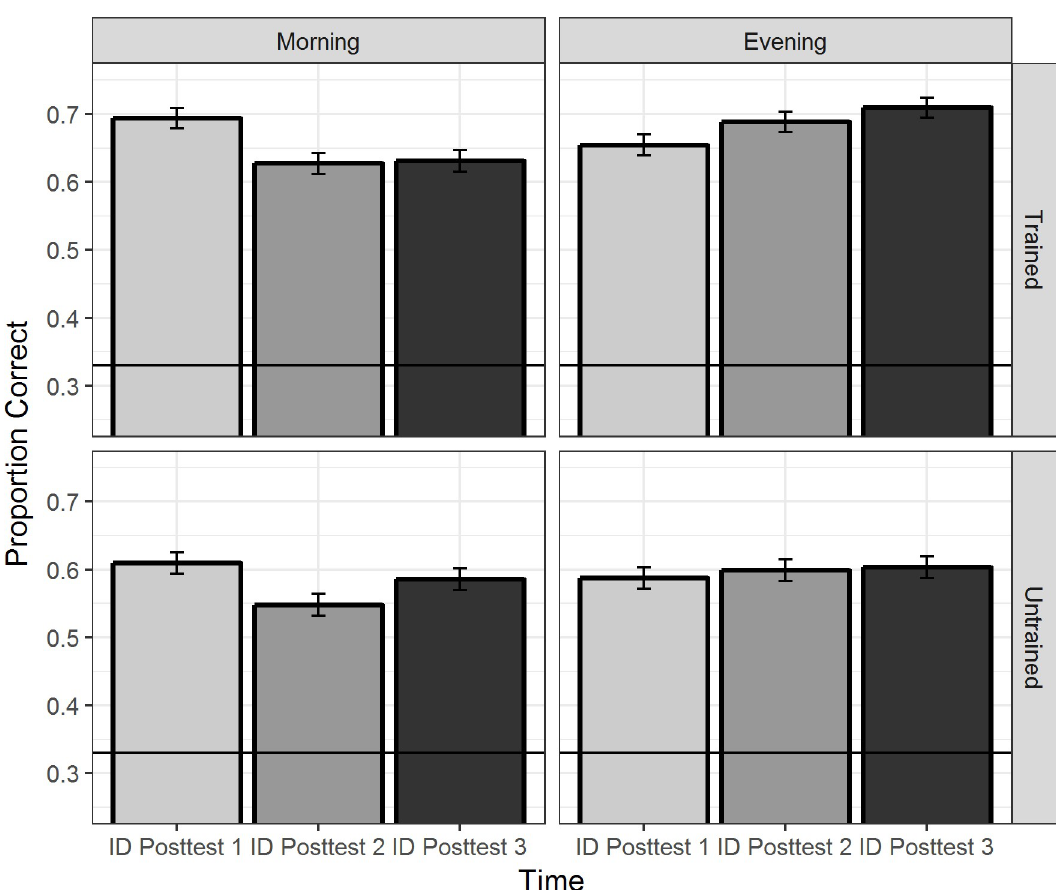
Fig 3. The morning and evening training groups’ mean proportions of correct response for stimuli produced by the trained and untrained talkers over the 24-hour period in the ID posttests. The error bars represent one standard error of the mean; the horizontal line represents chance